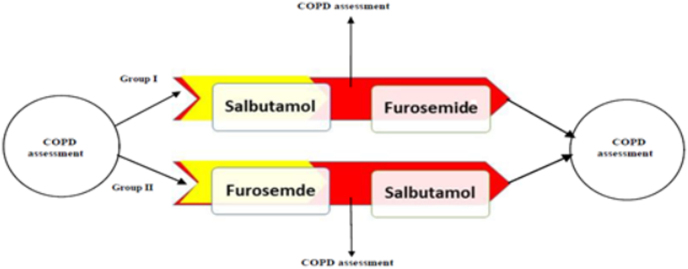
Study design: The yellow show the 1st and red arrows 2nd episodes. (For interpretation of the references to colour in this figure legend, the reader is referred to the Web version of this article.)